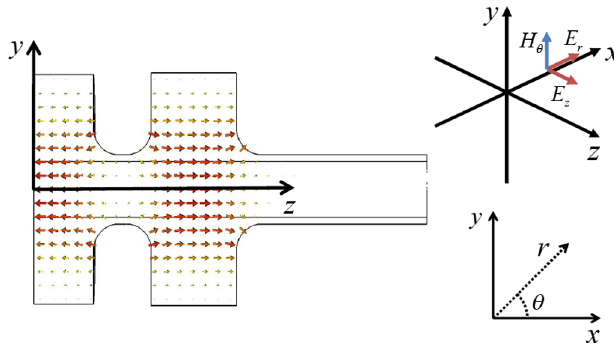
FIG. 2. Electromagnetic field distribution in the rf gun. The phase of the field is 0